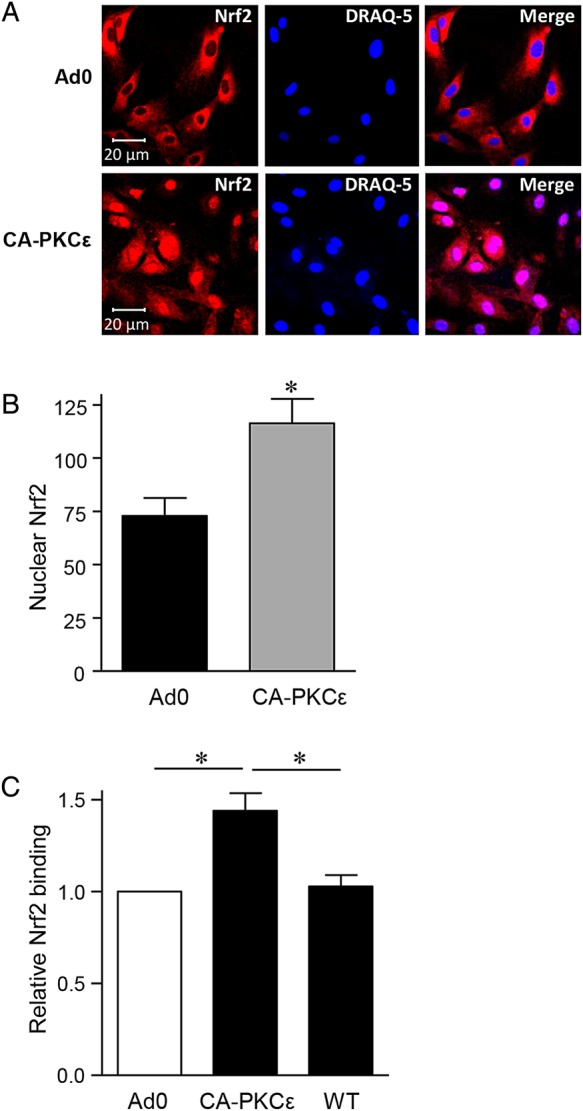
PKCε activation results in Nrf2 nuclear translocation. (A) HUVECs were transfected with CA-PKCε or Ad0 (MOI 100) for 16 h prior to staining with an anti-Nrf2 antibody and DRAQ-5 nuclear stain. Representative images are shown, and in (B) a histogram of pooled nuclear fluorescence data from five individual experiments, expressed as MFI of Nrf2 (mean ± SEM). (C) HUVECs were left UT or transfected with CA-PKCε or Ad0 (MOI 100) for 16 h. Nuclear lysates were generated and Nrf2 activation assessed using a DNA-binding ELISA in the presence and absence of a competitive WT oligonucleotide (WT), corresponding to the consensus sequence for Nrf2 binding. Pooled data (mean ± SEM) from at least four independent experiments are shown, corrected for tubulin expression where appropriate, and normalized to Ad0-transfected control cells (t-test, *P < 0.05).